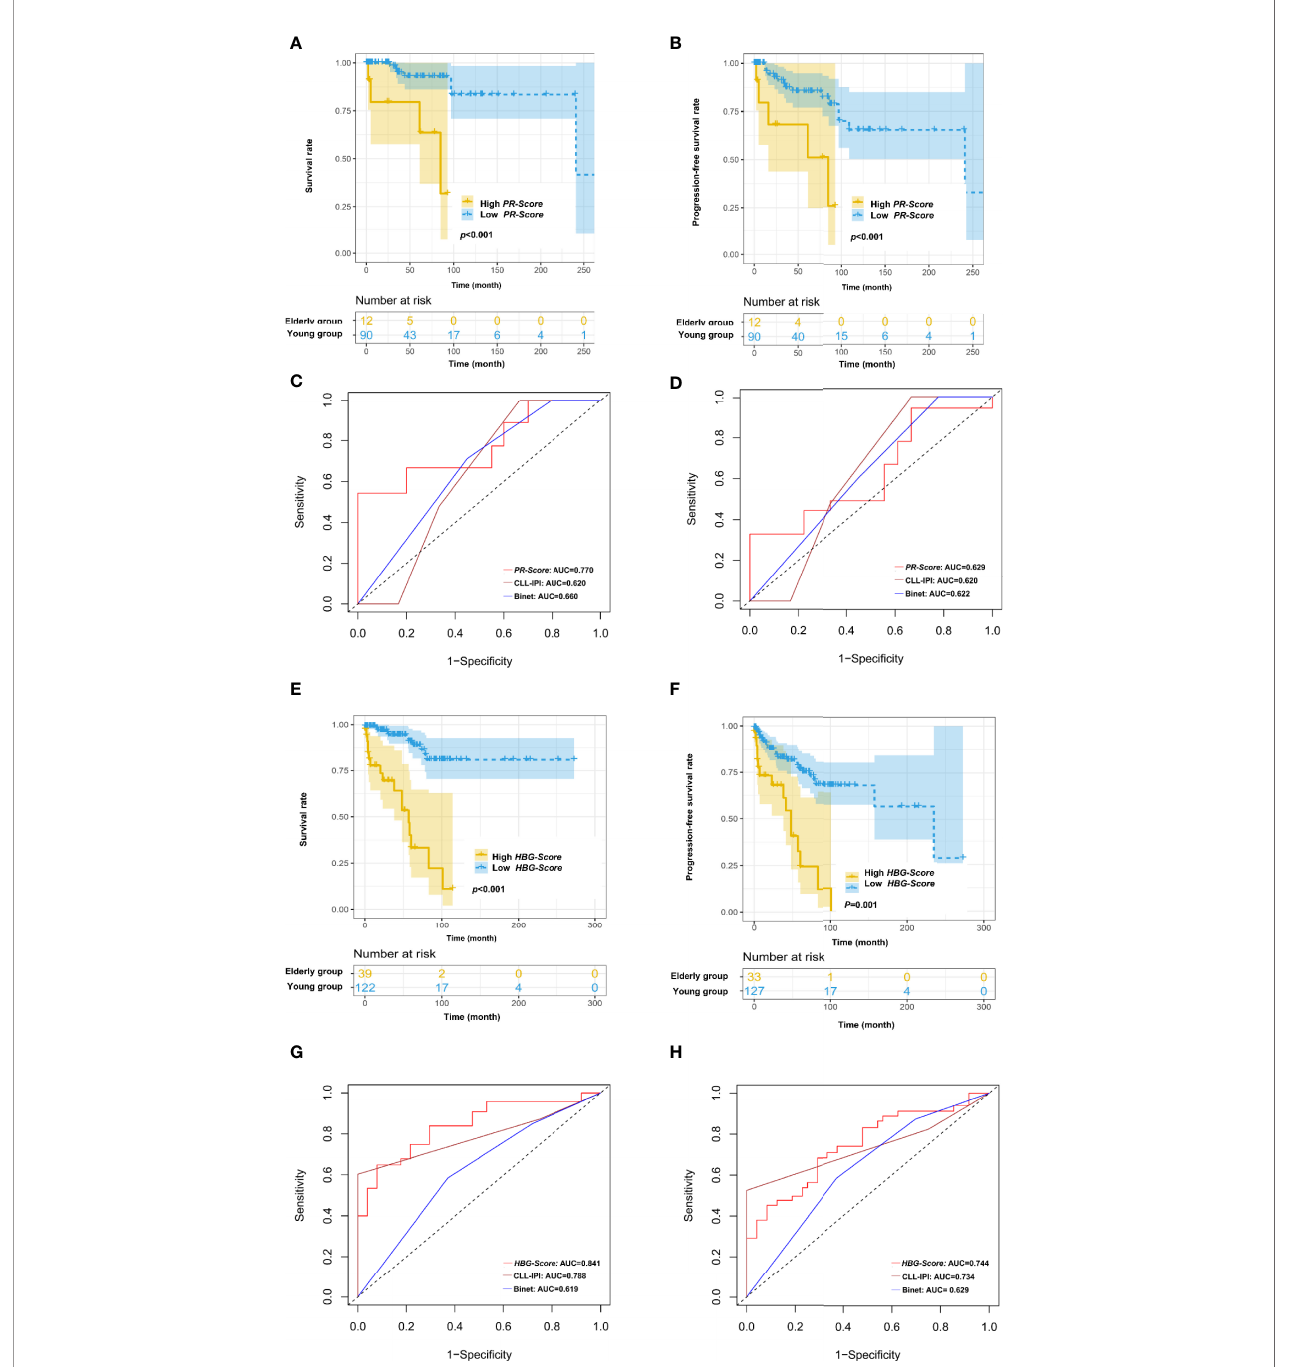
FIGURE 4 | Novel risk score models for young (<60 years old) and elderly ( ≥ 60 years old) CLL patients. (A) Increased PR-Score signi fi cantly correlated with shortened OS in young patients. (B) Increased PR-Score signi fi cantly correlated with shortened PFS in young patients. (C) PR-Score model showed advanced prognostic ability than international prognostic index for CLL (CLL-IPI) and Binet stage in predicting OS of young patients. (D) PR-Score model showed advanced prognostic ability than CLL-IPI and Binet stage in predicting PFS of young patients. (E) Increased HBG-Score signi fi cantly correlated with shortened OS in elderly patients. (F) Increased HBG-Score signi fi cantly correlated with shortened PFS in elderly patients. (G) HBG-Score model showed advanced prognostic ability than CLL-IPI and Binet stage in predicting OS of elderly patients. (H) HBG-Score model showed advanced prognostic ability than CLL-IPI and Binet stage in predicting PFS of elderly